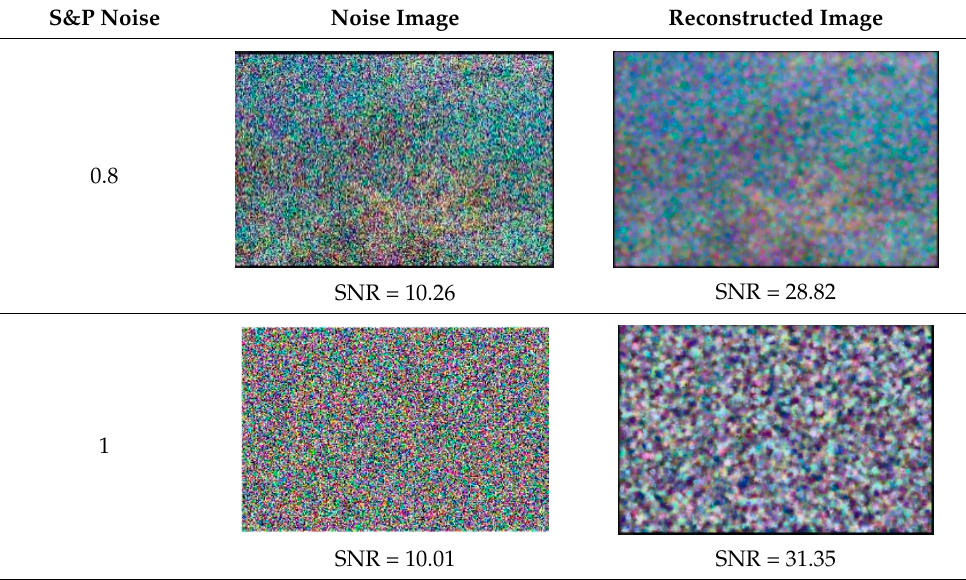
Table 6. Average Runtime for Different Image Sizes (In Second).